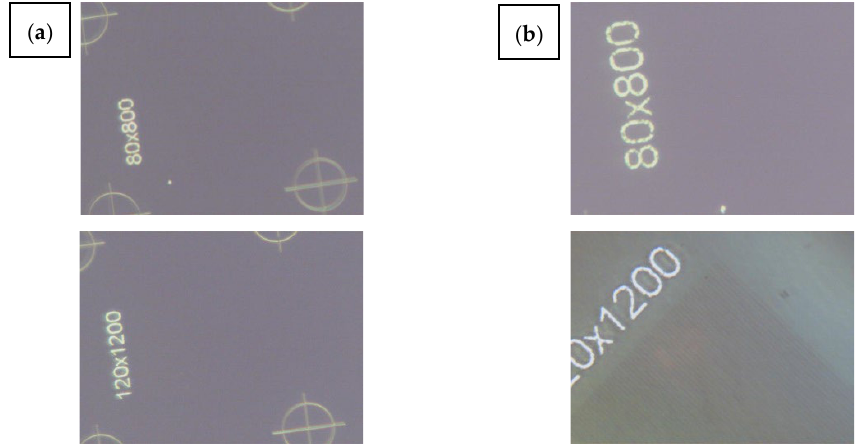
Figure 6. Images of short dipole structures in transmittance microscopy at visible wavelengths; whole dipole arrays ( a ); details of dipole arrays ( b ).